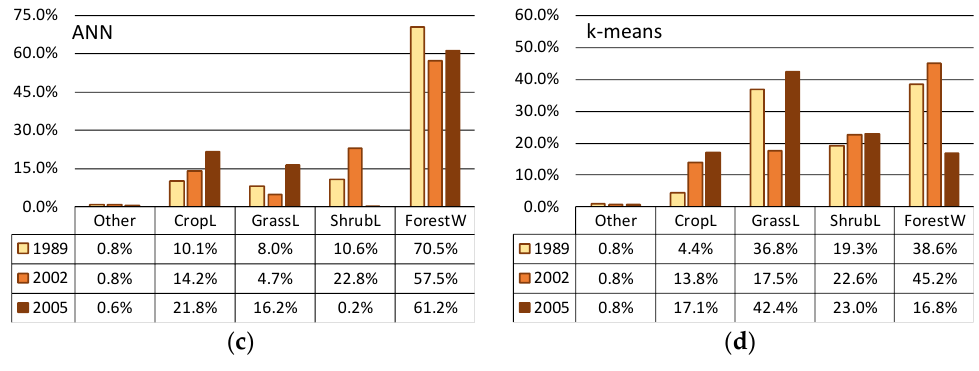
Figure 4. Land cover areas distribution along the three-year study for the four classification methods: ( a ) FF-Uninorm; ( b ) Decision Tree; ( c ) Artificial Neural Network; ( d ) k-means clustering.